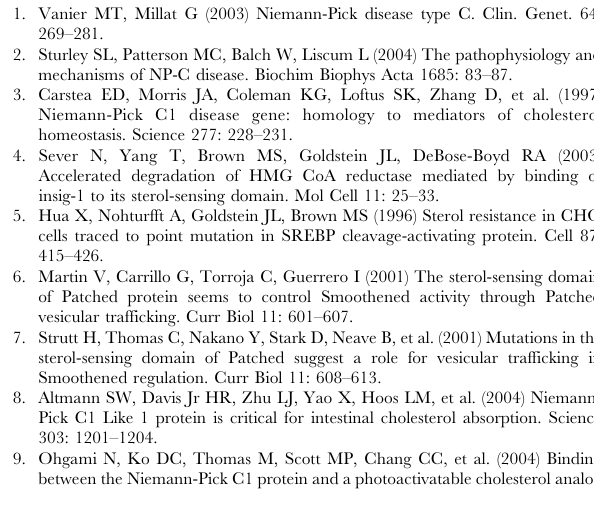
Table S3 Genes involved in membrane traffic and the cytoskeleton that are upregulated in NPC fibroblasts.